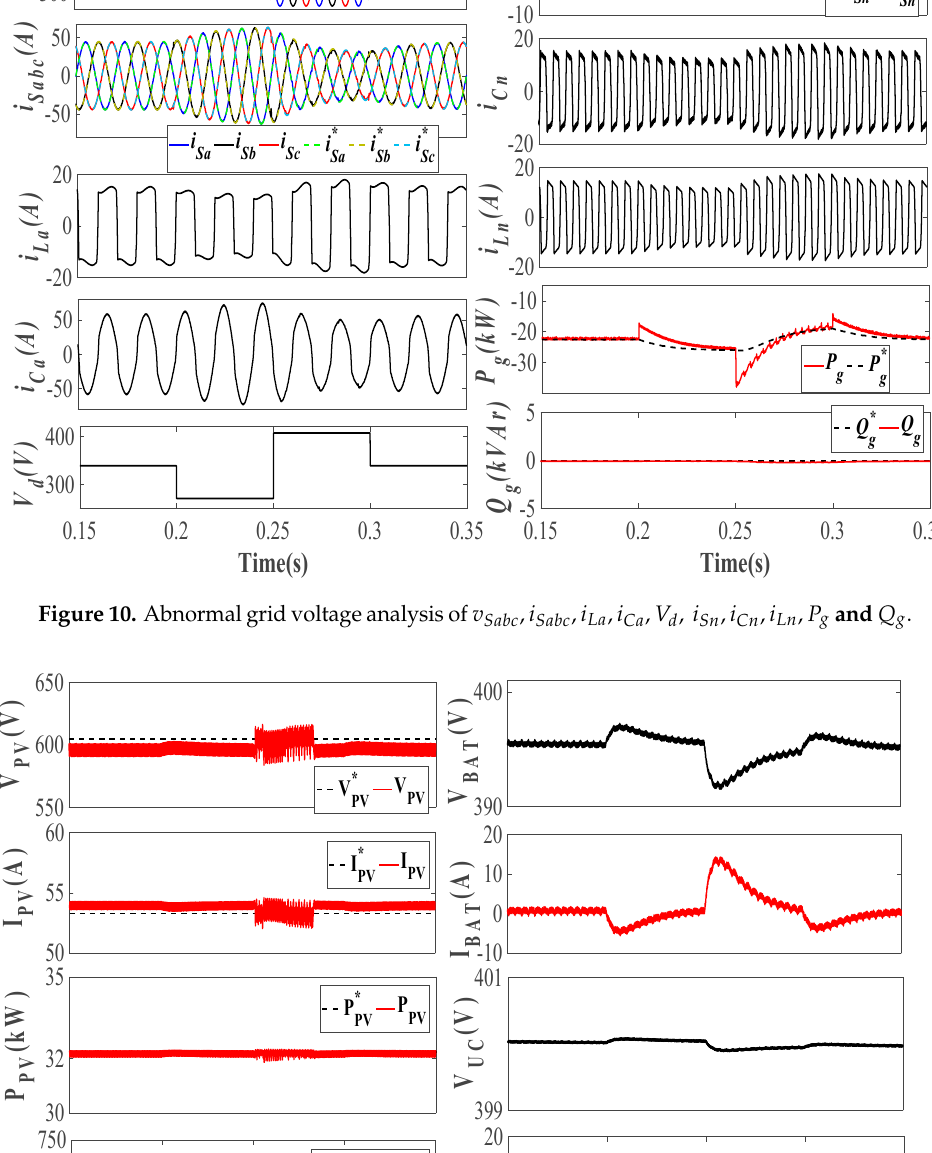
Figure 11. Abnormal grid voltage analysis of V PV , I PV , P PV , V DC , V BAT , I BAT , V UC , and I UC